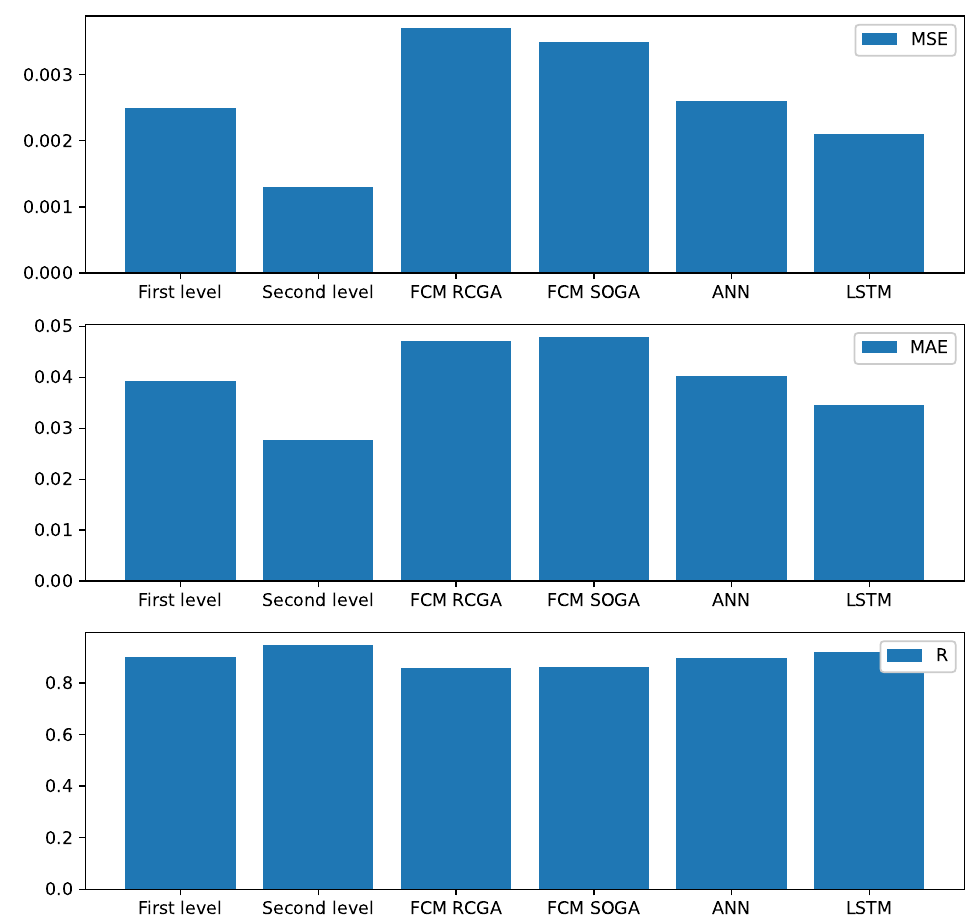
Figure 7. Forecasting metrics: MSE, MAE and R obtained for the compared